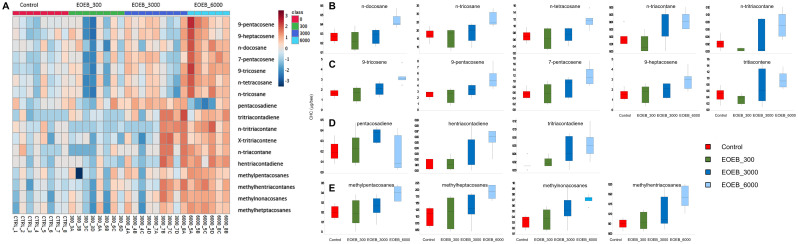
Agglomerative, hierarchical cluster analysis on the individual CHC in honeybees fed on EO-enriched diets at different doses: Heatmap (A, distance measured using Euclidean, and clustering algorithm using ward.D in Metaboanalyst [44]). The colored boxes on the right indicate the relative concentrations of the corresponding metabolite in each group under study. Boxplots of the selected CHC that accounted for significant differences (identified from variable importance in projection (VIP) in a PLS-DA: B, linear alkanes; C, Alkenes, D, Alkadienes and E, branched alkanes. Boxes represent 95%-intervals around the media (horizontal bar within a box) calculated as 1.58*IQRT /sqrt(n).